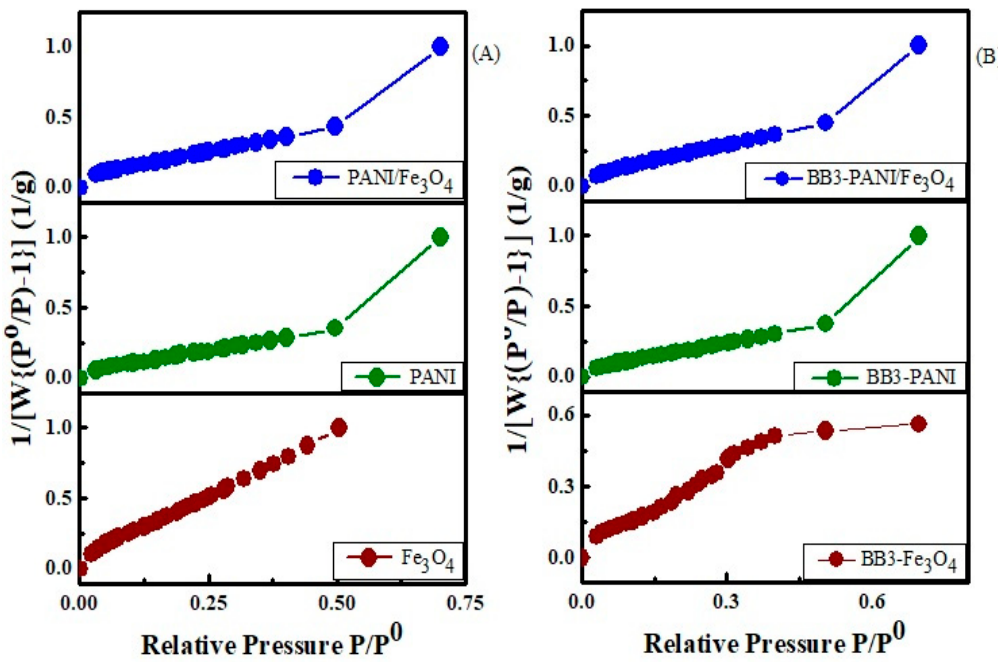
Figure 6. Surface area analysis of ( A ) Fe 3 O 4 , PANI, and PANI / Fe 3 O 4 before and ( B ) after adsorption of BB3. Table 1. Surface area and Barrett, Joyner, and Halenda (BJH) para meters of Fe 3 O 4 , PANI, and PANI / Fe 3 O 4 composites before and after adsorption of BB3